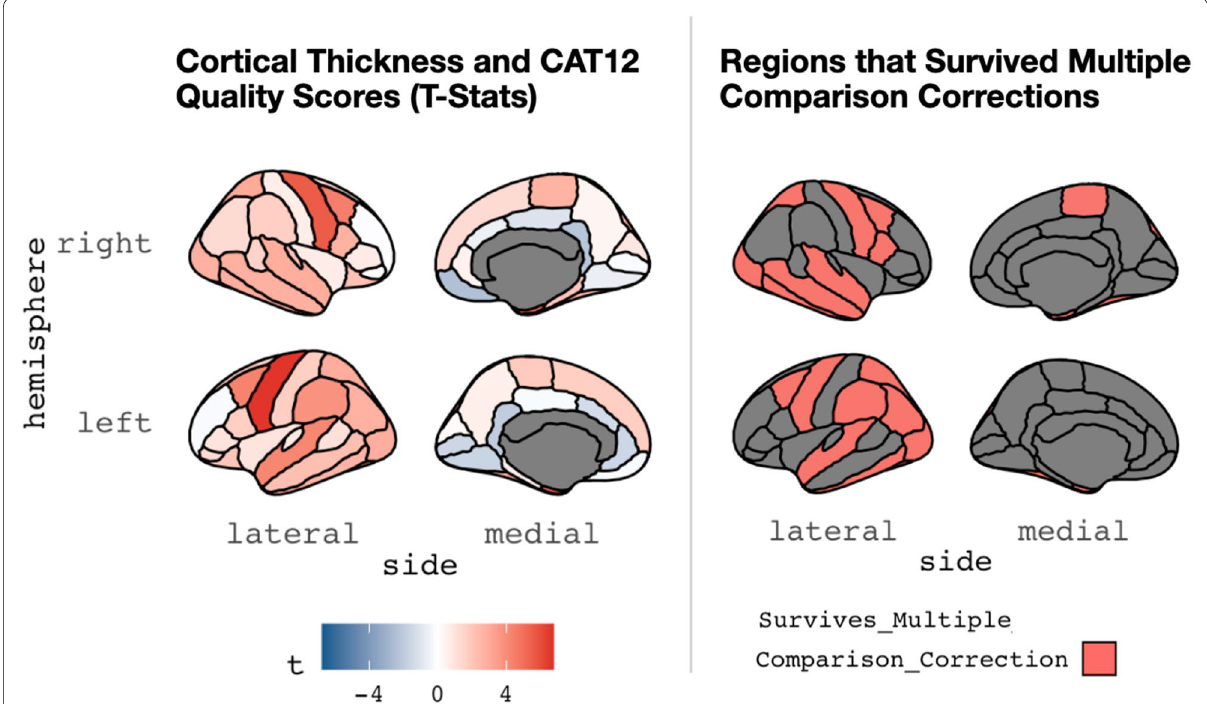
Fig. 6 A graphic depiction (from the R library ggseg ) showing associations between image quality (assessed by the CAT12 Toolbox) and derived (mean) cortical thickness. This is shown for the DK atlas commonly used in Freesurfer. Lateral and medial views are shown for the right (top) and left (bottom) hemispheres. The left panel shows the overall t-statistics for the relation in each parcel, while the right panel shows parcels where the relation between cortical thickness and image quality survives multiple